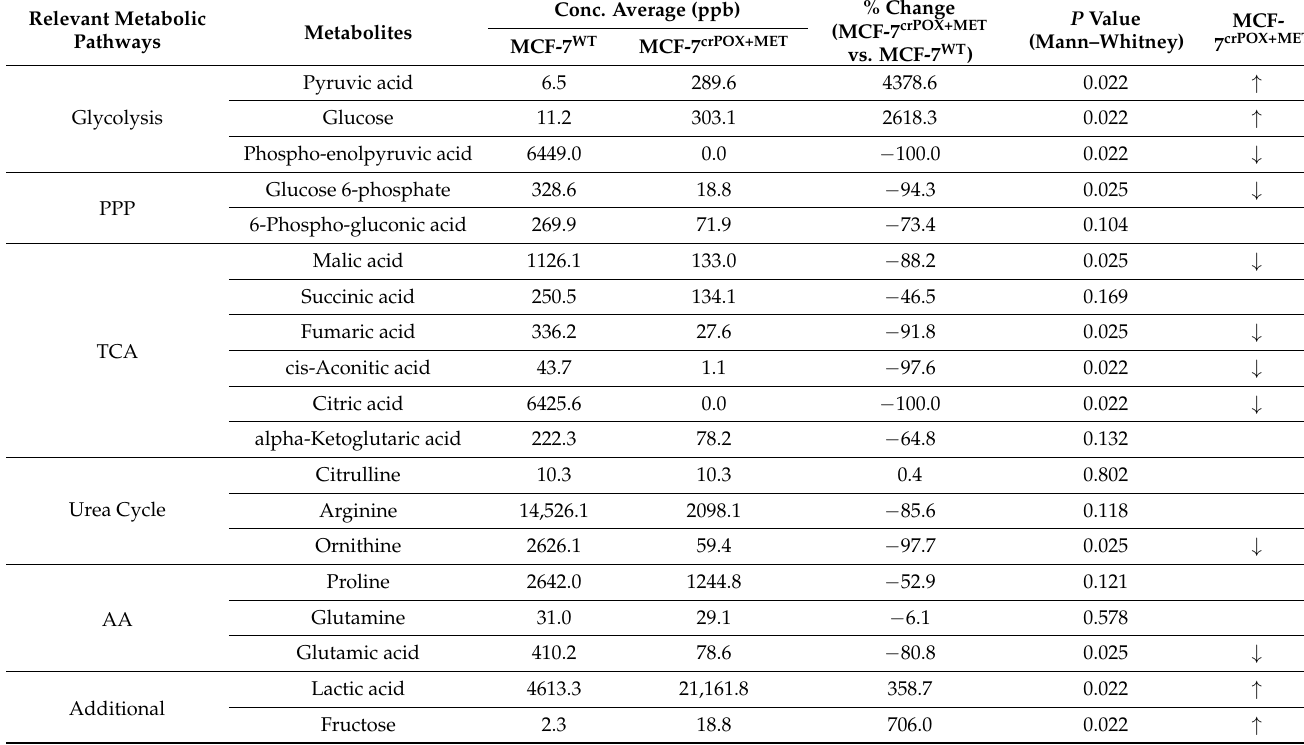
Table 3. Targeted metabolic profiles of some metabolites of glycolysis, pentose phosphate pathway, TCA and urea cycles in MCF-7 crPOX treated with MET (MCF-7 crPOX+MET ) and in MCF-7 WT cultured in Gln free medium. AA—amino acids, PPP—pentose phosphate pathway, TCA—tricarboxylic acids cycle. ↑ —significant increase in the concentration of